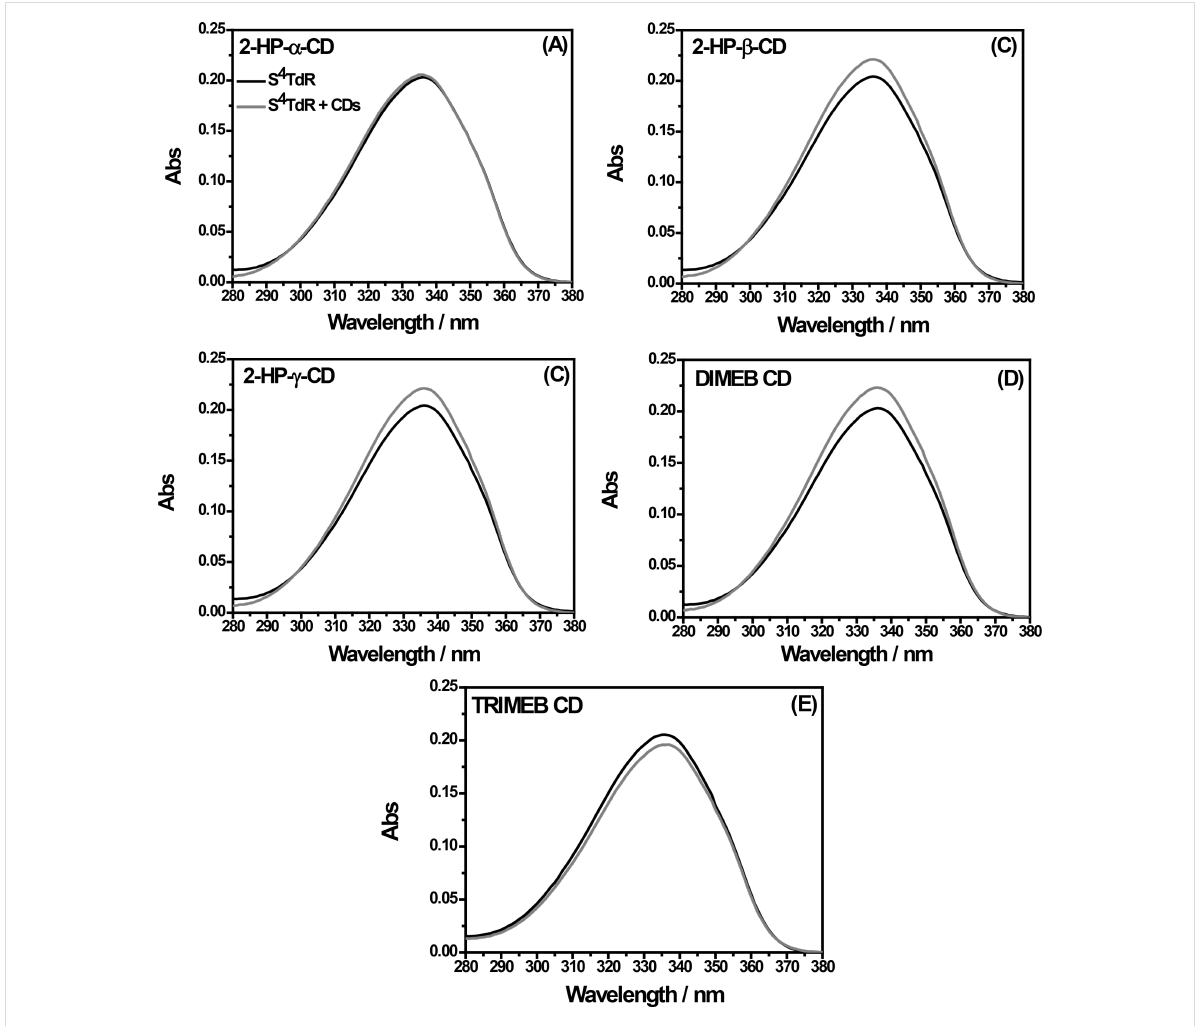
Figure 2: Comparison between UV–vis absorption spectra (detailed view: 280–380 nm) obtained for 1 × 10 − 5 M aqueous solutions of S 4 TdR in absence of CDs (black line), and in presence of CDs (dark gray line), added at a molecular ratio of 1:1. The solution pH is 7.